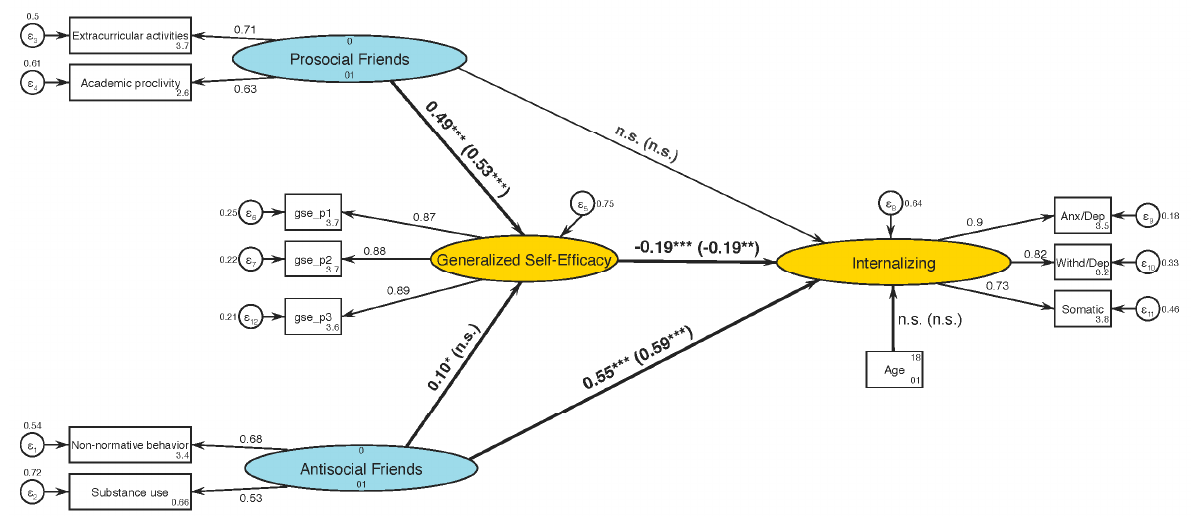
Figure 1. Structural Equation Model. Final structural equation model representing effects of prosocial and antisocial friends and generalized self-efficacy on past 6 months youth self-report of internalizing problems among 1545 Ukrainian schoolchildren aged 11–13 years. Ellipses represent latent constructs. The paths are shown as straight lines and the values along the lines are standardized path coefficients significant at n.s. = “non-significant”, * p < 0.05, ** p < 0.01, *** p < 0.001 for girls (first values) and boys (parenthesized values).